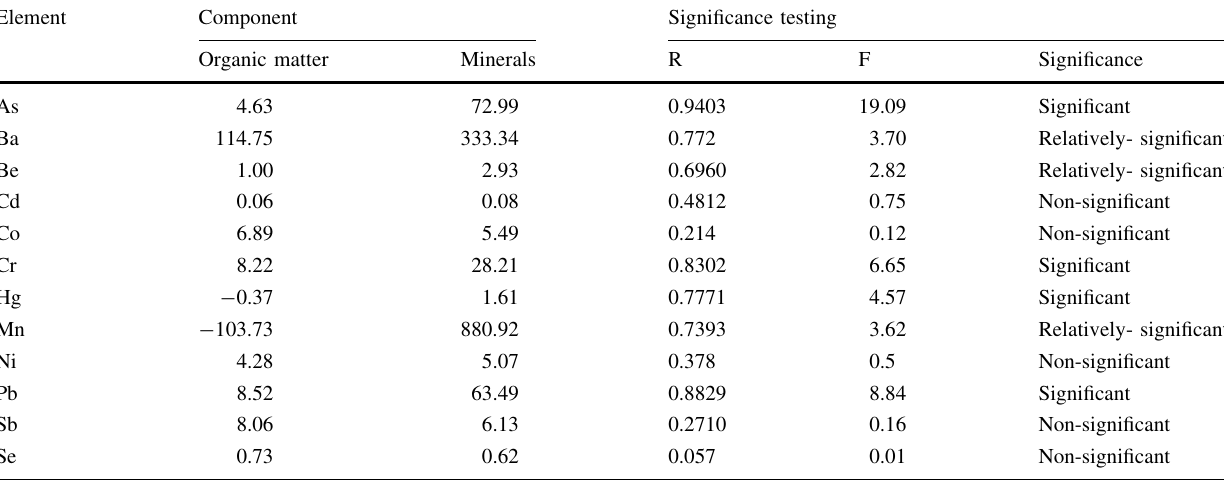
Table 7 Theoretical trace element contents in the organic matters and in the minerals of No.14 coal from Houlinhe, calculated value ( l g/g)